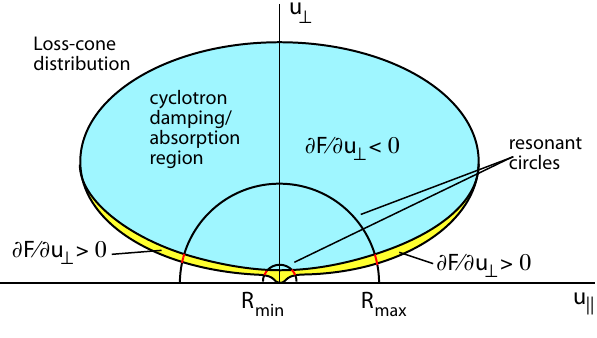
Fig. 4. Electron loss-cone (Dory-Guest-Harris) distribution in the normalised 4-velocity plane. Shown are two resonance circles for maximum and minimum radii, corresponding to minimum and maximum unstable electron cyclotron maser emissions in perpen- dicular propagation of R-X- modes. The section of the resonance circles contributing to emission are shown in red. Emission is pro- vided as long as the phase space gradient over the positive (yellow) part is steep enough to compensate for the larger part of the circles traversing the blue negative gradient region of the distribution. Note that the blue region between the circles of maximum and minimum resonances R max ,R min absorbs electron-cyclotron waves by damping them. This heats the electrons in this domain and flattens the distribution in this region of phase space.